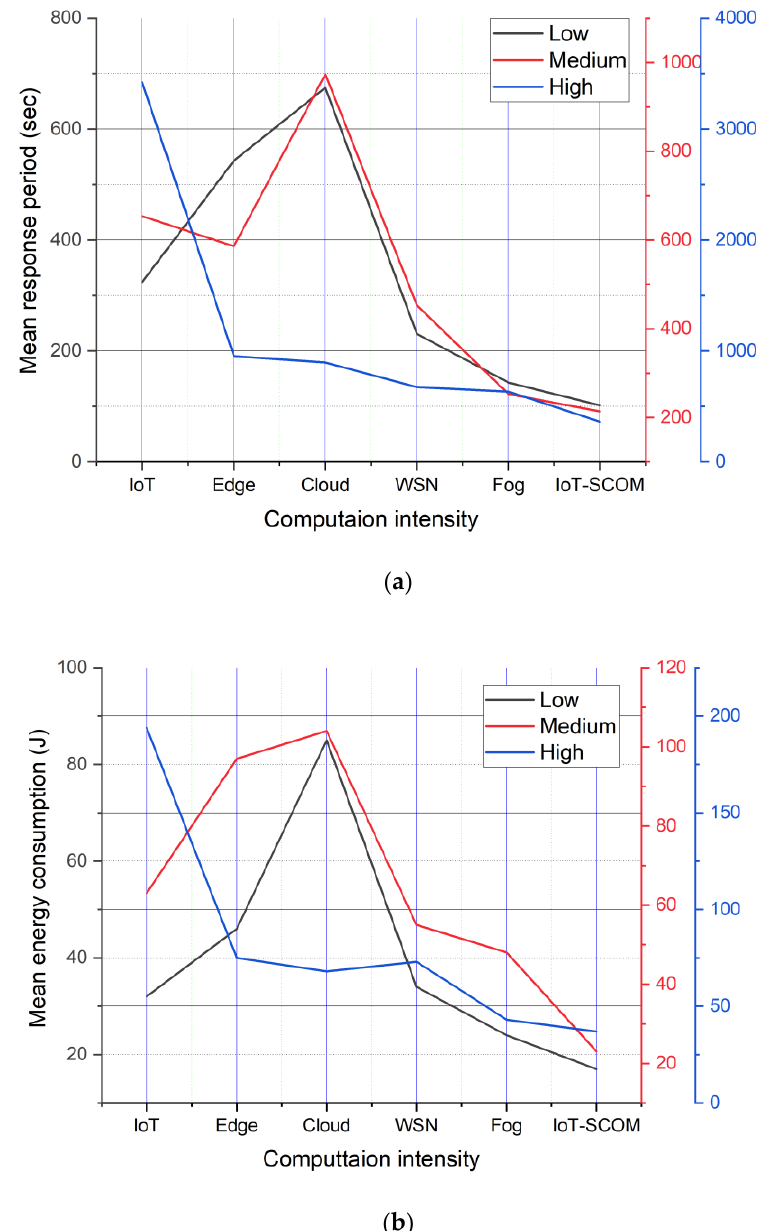
Figure 5. ( a ) Response period analysis. ( b ) Energy consumption analysis. The results are compared to the existing IoT-SCOM.The service component 𝑆 𝑐 is used to compute the transmission power of the IoT devices, cloud layer, and edge layer namely 𝑃 𝑡 (𝑇 𝑥 , 𝐷), 𝑃 𝑡 (𝑇 𝑥 , 𝐶) 𝑎𝑛𝑑 𝑃 𝑡 (𝑇 𝑥 , 𝐸) . The response time is computed from the request arising time to the service component processing time. The fitness level evaluation of the IoT-SCOM is computed using the different service components, and the outcomes are shown in Figure 6. The simulation outcomes of the IoT-SCOM are evaluated by varying the fitness trend from 0.5, 0.8, and 1.0. As the fitness trend increases, the respective fitness level 𝐹(𝐷 𝑝 ) . The epoch size varies from 100 to 300, with an incremental level of 20. The task burden 𝐵 𝑇 𝑥 is indirectly related to fitness level, and as the task burden increases, the individual fitness level is decreased. The transmit- ted power of different layers 𝑃 𝑡 (𝑇 𝑥 , 𝐷), 𝑃 𝑡 (𝑇 𝑥 , 𝐶) 𝑎𝑛𝑑 𝑃 𝑡 (𝑇 𝑥 , 𝐸) are affected by the fitness